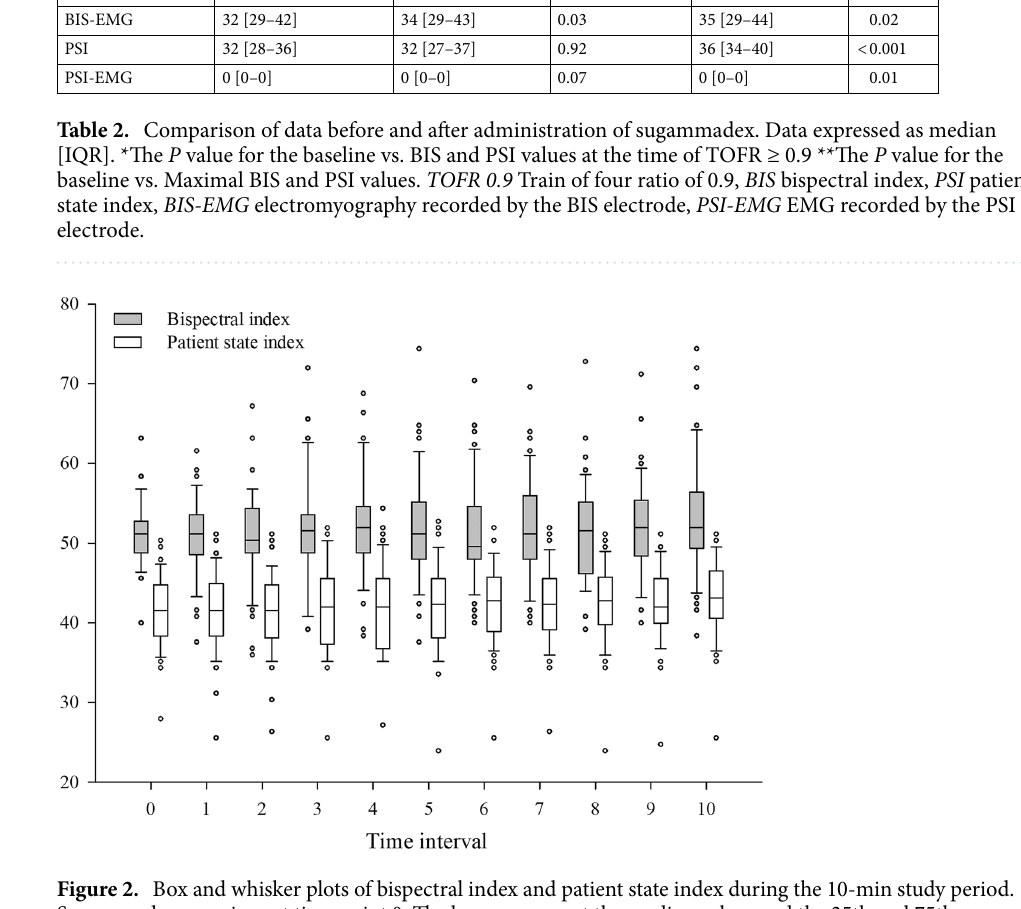
Figure 2. Box and whisker plots of bispectral index and patient state index during the 10-min study period. Sugammadex was given at time point 0. The boxes represent the median values and the 25th and 75th percentiles. The whiskers represent the minimum and maximum values, excluding outliers. The points represent the